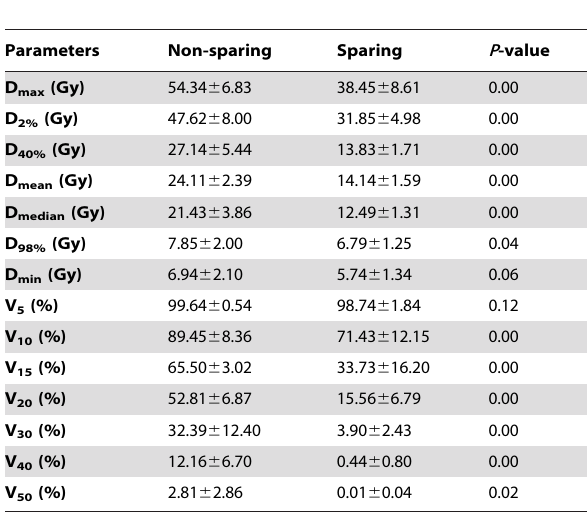
Table 5. Hippocampal dosimetric and volumetric parameters for different IMRT